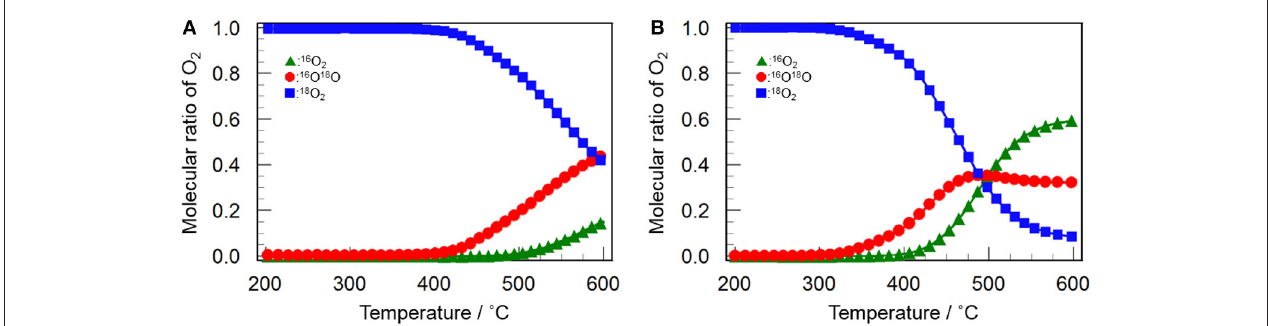
FIGURE 9 | Change in the molecular ratio of 16 O 2 (green triangles), 16 O 18 O (red circles) and 18 O 2 (blue squares) during the isotopic exchange reaction of O 2 over (A) Y 2 O 3 and (B) CeO 2 ( 3 )/Y 2 O 3 (CP) as a function of